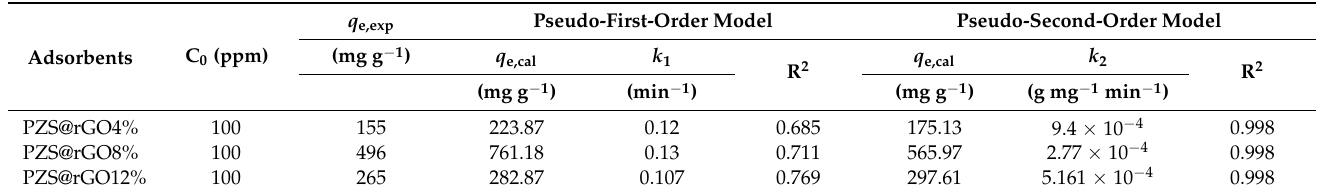
Table 1. Adsorption parameters for pseudo-first-order and pseudo-second-order models.